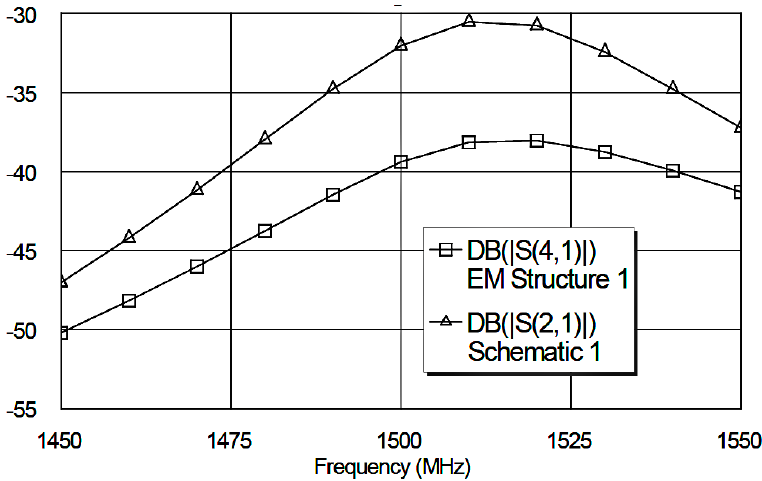
Figure 14. Simulation results of microwave signal transmission by passive and active antenna ele- ment